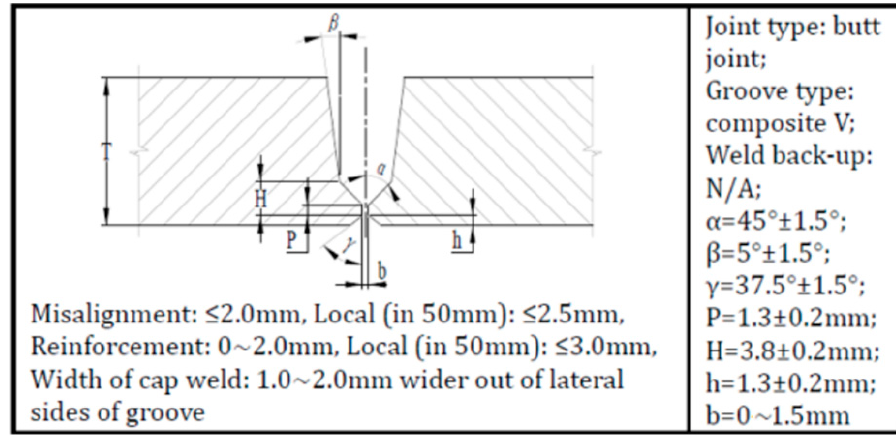
Table 1. Chemical composition and carbon equivalent of target X80 pipe steel (wt.%).